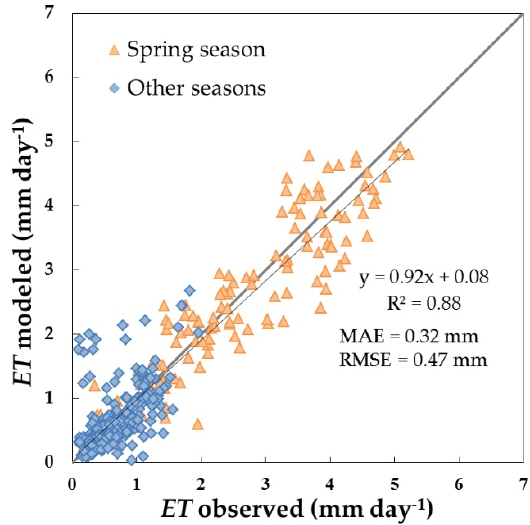
Figure 8. Comparison between observed and modeled daily evapotranspiration ( ET ) values over the grass area (mm) for the hydrological years 2015–2016 and 2016–2017. Root Mean Square Error (RMSE) and Mean Absolute Error (MAE) are presented in the figure.